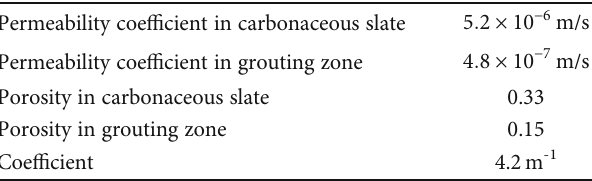
Table 3: Pore permeability